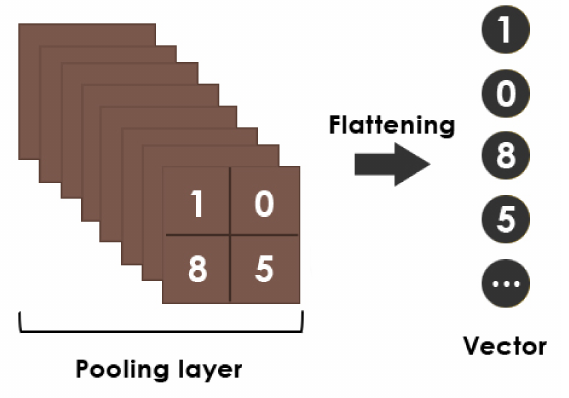
Figure 9. Representation of the flattening